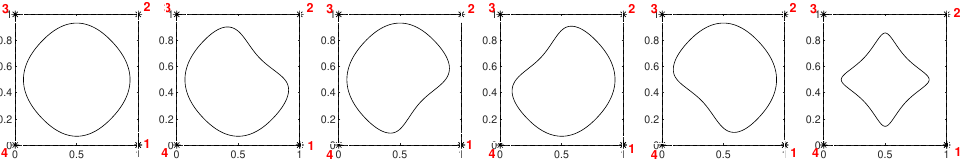
Figure 6. Curves generated by the non-uniform version of the scheme { S a k } k ≥ 0 with v 0 = − 0.8 and ( β ) = ( 0,0,0,0 ) , ( 0.6,0,0,0 ) , ( 0,0.6,0,0 ) , ( 0,0,0.6,0 ) , ( 0,0,0,0.6 ) , ( 0.6,0.6,0.6,0.6 ) (from 1 , β 2 , β 3 , β 4 left to